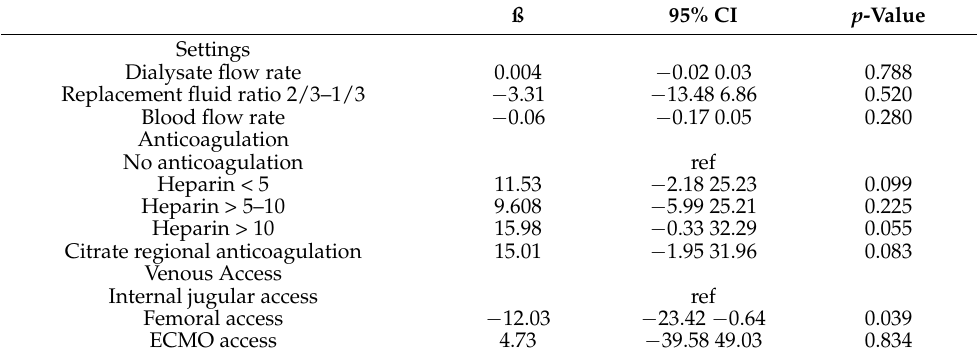
Table 4. CRRT setting and filter lifespan in whole cohort.